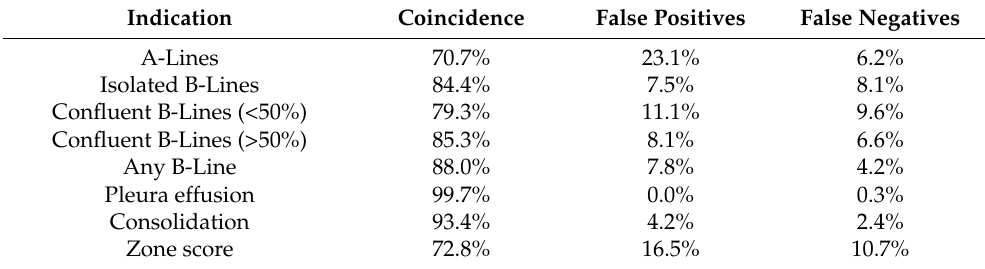
Table 2. Comparison between the indications detected by the automated algorithm and the expert. Indication Coincidence False